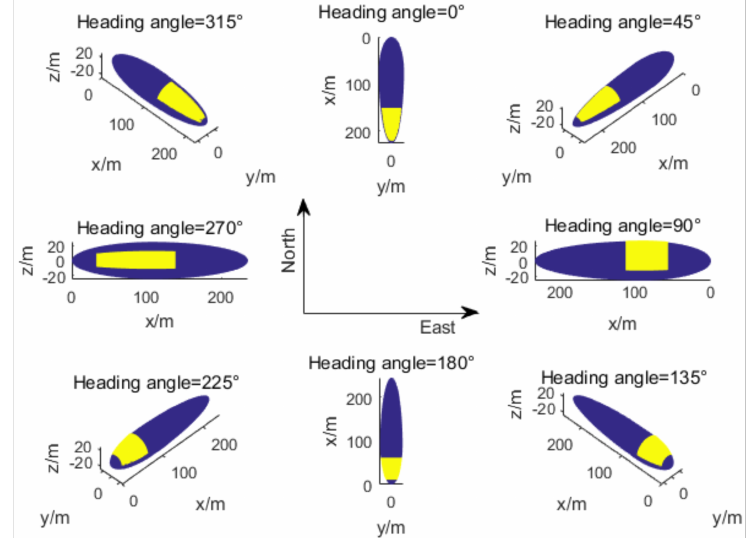
Figure 17. The optimized layouts of the solar array for different heading angles.